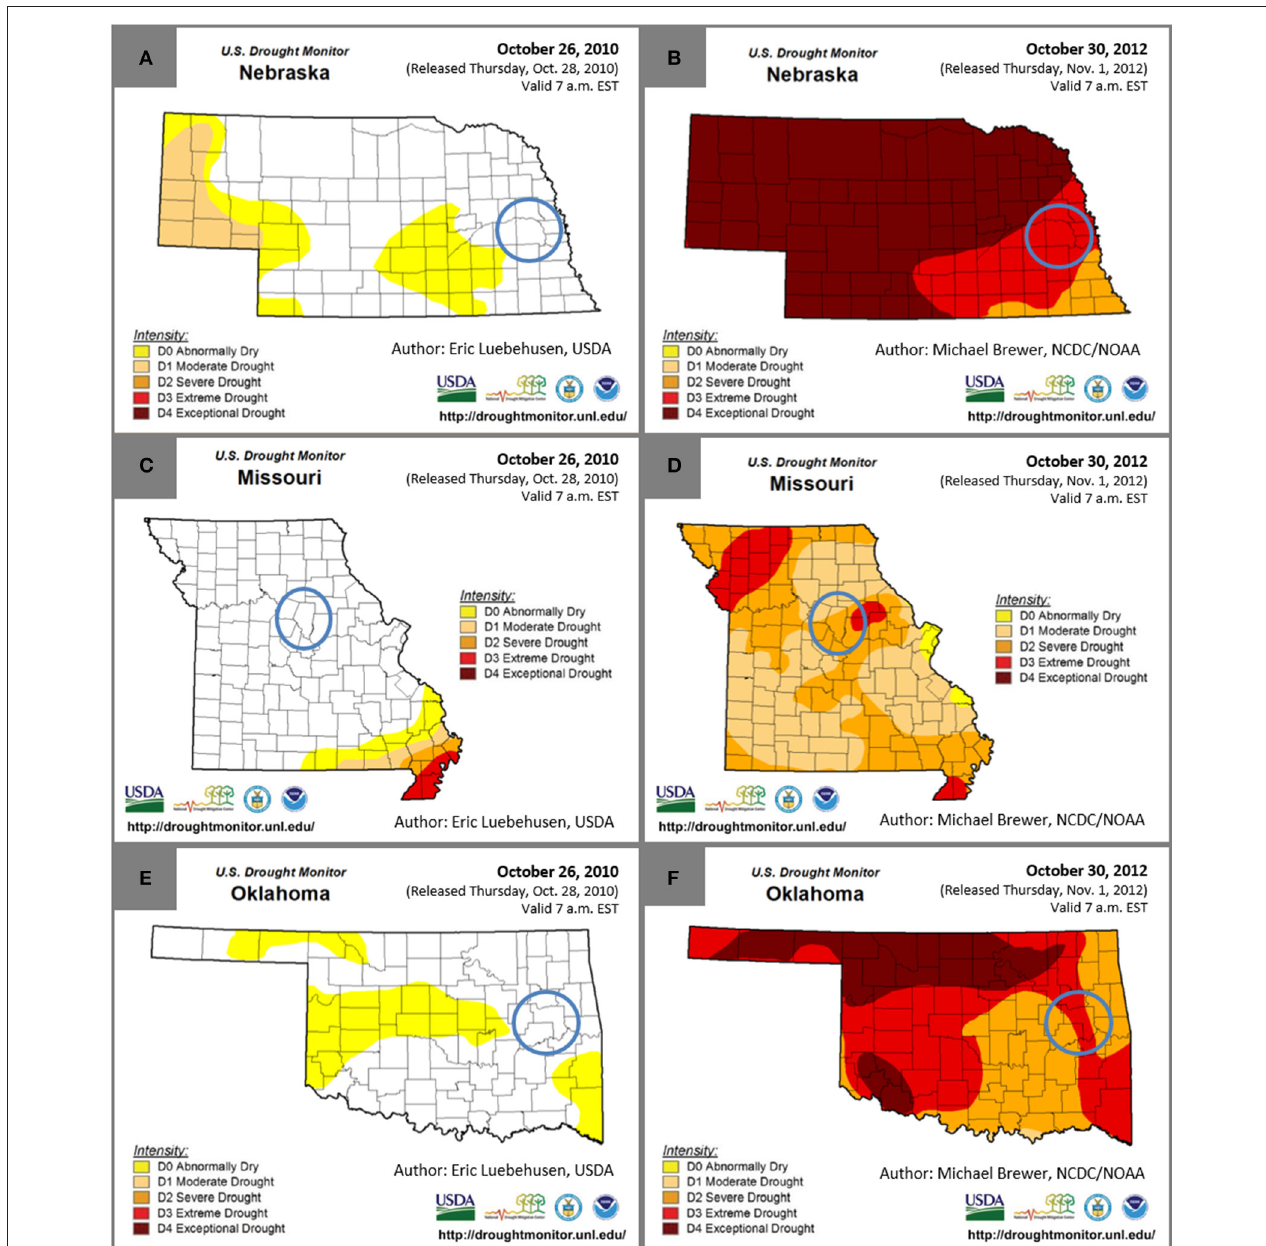
FIGURE 1 | Drought conditions at the end of October in 2010 and 2012 for Nebraska (A,B) , Missouri (C,D) , and Oklahoma (E,F) . Blue circles indicate the county that Miscanthus was grown in Nebraska, the tall fescue mixture was grown in Missouri, and switchgrass was grown in Oklahoma.